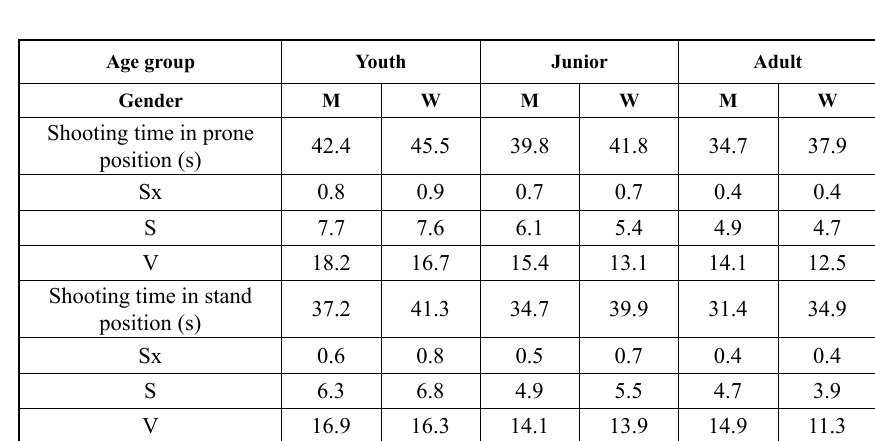
Note. Sx – standard error, S – standard deviation, V – variance of the mean; * – Biathletes who achieved 1 st –8 th places in youth women and adult men groups were considered as leaders. In other groups leaders’ results calculation was based on data from biathletes who took 1 st –3 rd places.